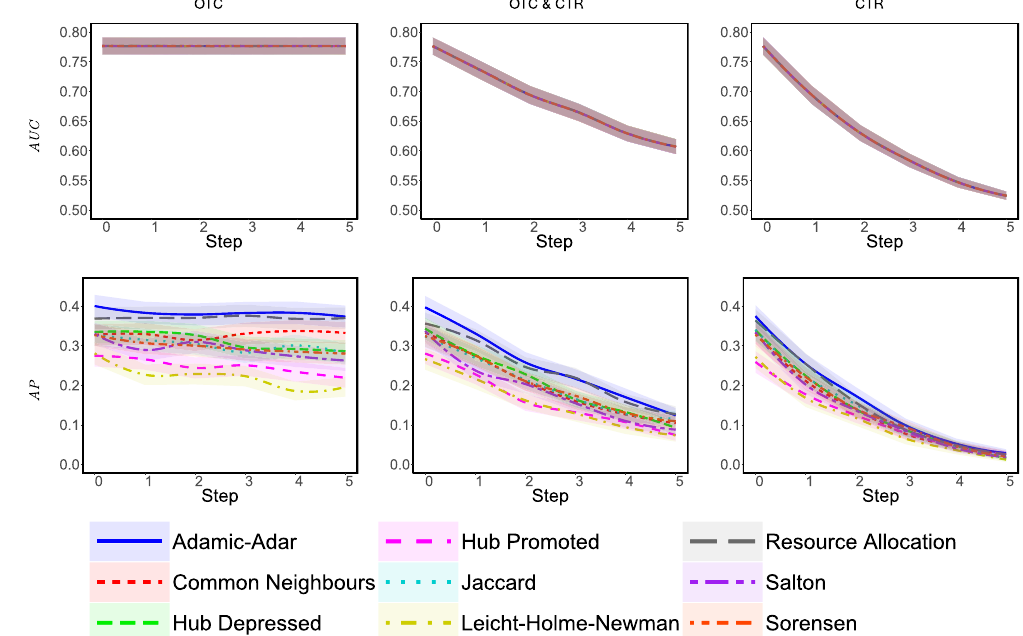
Figure 3. Given different similarity indices and a telecommunication network consisting of 248,763 nodes and 829,725 edges, the figure depicts the average AUC and AP during the execution of OTC and CTR with a budget b = 5. For each similarity index, we consider 10 different, randomly-chosen evaders that have at least 9 connections each (to ensure that no evader is entirely disconnected when running CTR); for each such evader, we create 5 sets of H , each consisting of 3 edges chosen randomly from the evader’s connections. This yields a total of 50 experiments, the average of which is reported with the coloured areas representing the 95% confidence